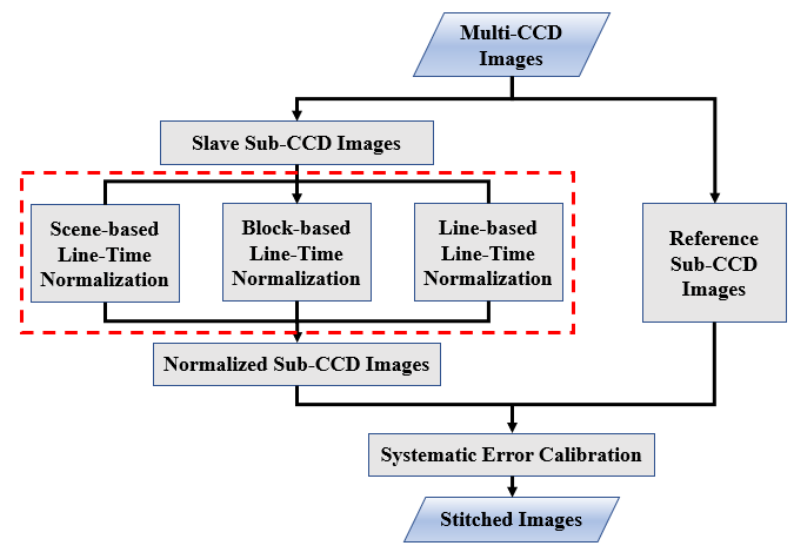
Figure 3. Work-flow of the proposed